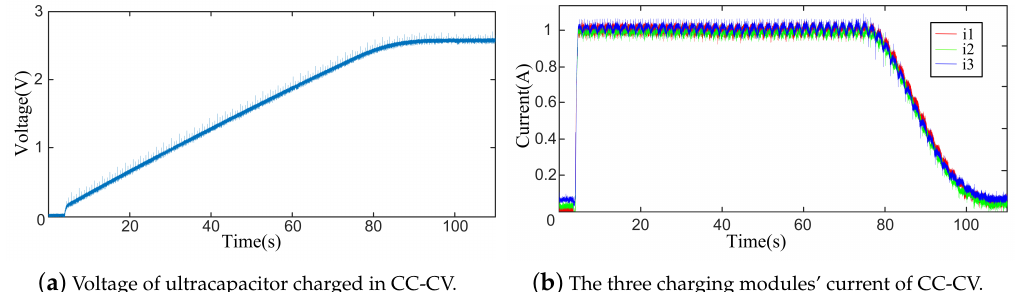
Figure 9. The CC-CV charging